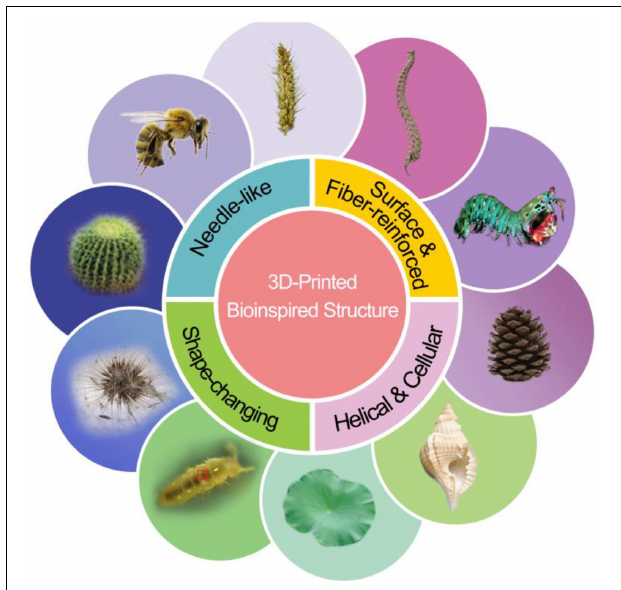
FIGURE 1 | 3D-printed bioinspired structures including geometric (hierarchical, helical, cellular, and needle-like) and functional (surface, fiber-reinforced, and shape-changing)